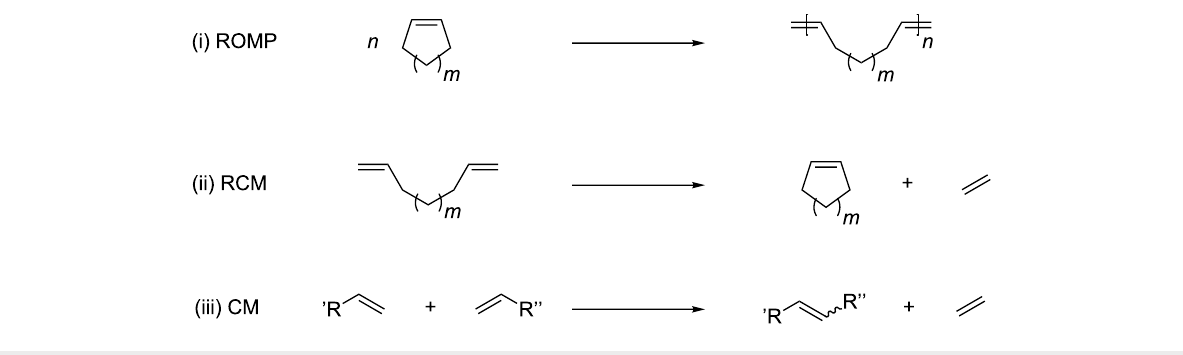
hydratase (cobalt(III) in the active site) for the production of acrylamide have found application in industry [25]. Notably, however, the reaction scope of natural enzymes is quite